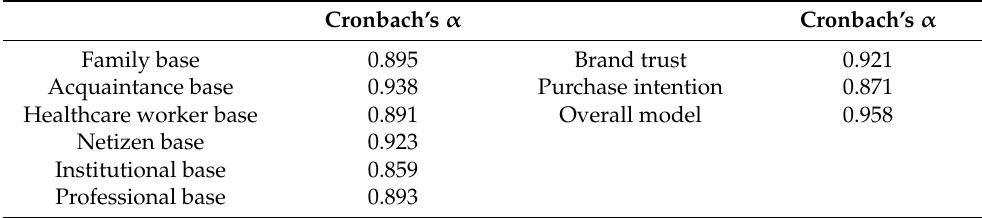
Table 1. Reliability analysis of the